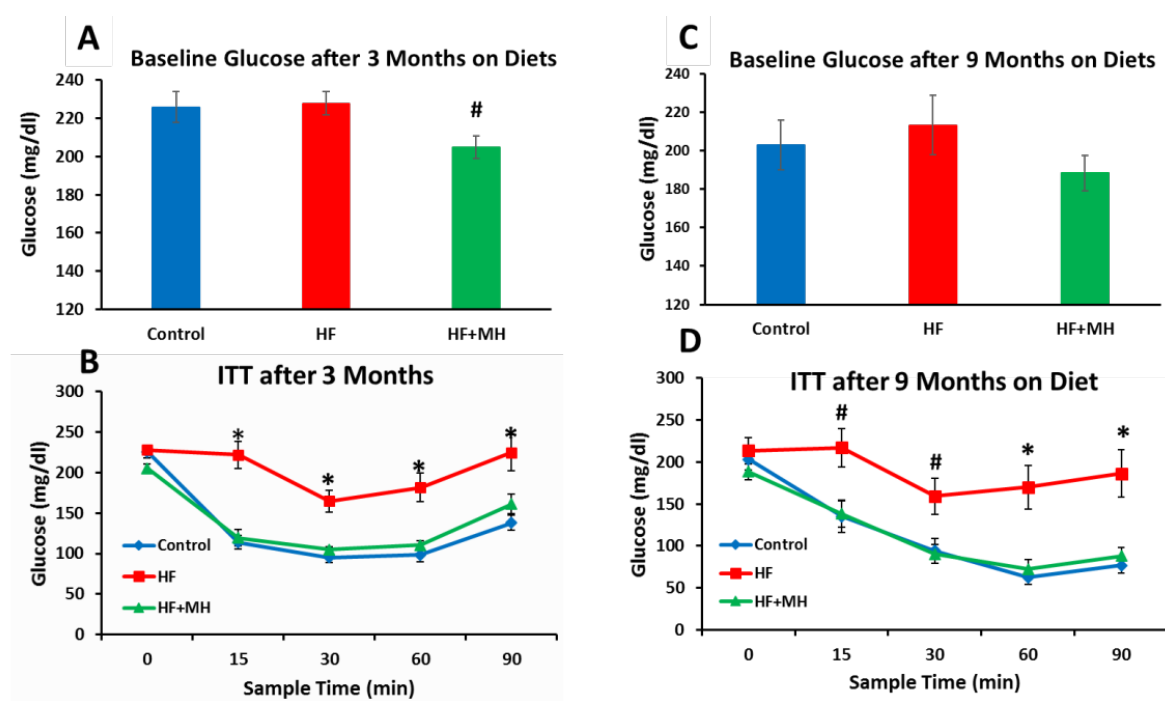
Figure 4. ( A ): Baseline glucose after 3 months on diets (Ns = 15–16). ( B ): Insulin tolerance test (ITT) after 3 months on diets (Ns = 15–16). ( C ): Baseline glucose after 9 months on diets (Ns = 7–8). ( D ): ITT after 9 months on diets (Ns = 7–8). * = p < 0.01 compared to controls. # = p < 0.05 compared to controls.